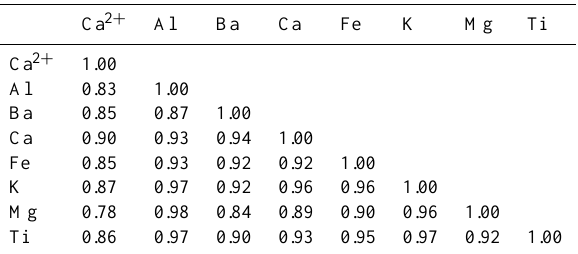
Table 4. Correlation coefficients of dust-derived species in PM 10 during spring ( n = 24, p = 0 .